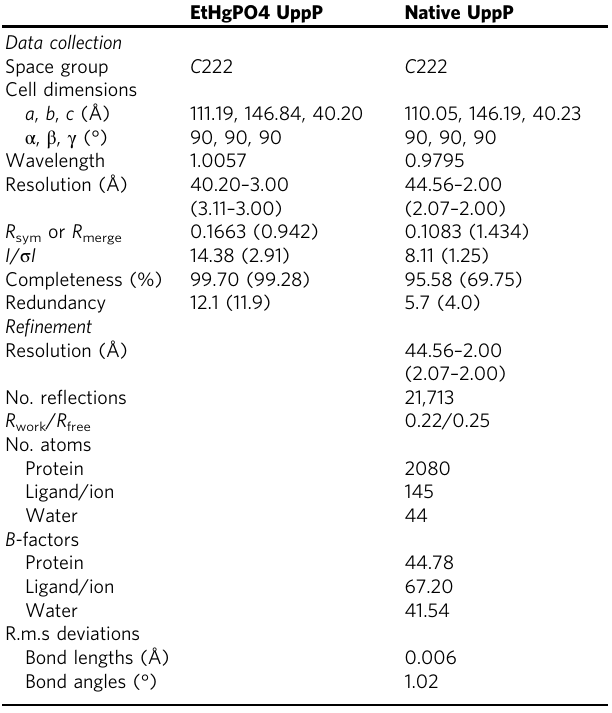
Table 1 Data collection and re fi nement